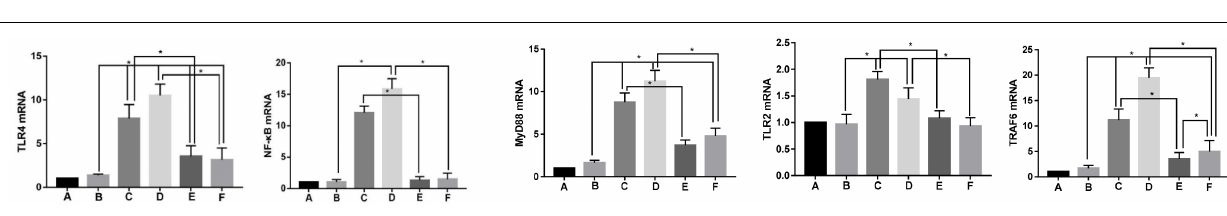
FIGURE 6 | mRNA expression levels of TLR2, TLR4, NF- κ B, MyD88, and TRAF6 in the synovium of rabbit joints in each group. Note (A) Group B; (B) Group S; (C) Group M1; (D) Group M2; (E) Group EA1; and (F) Group EA2. * P <